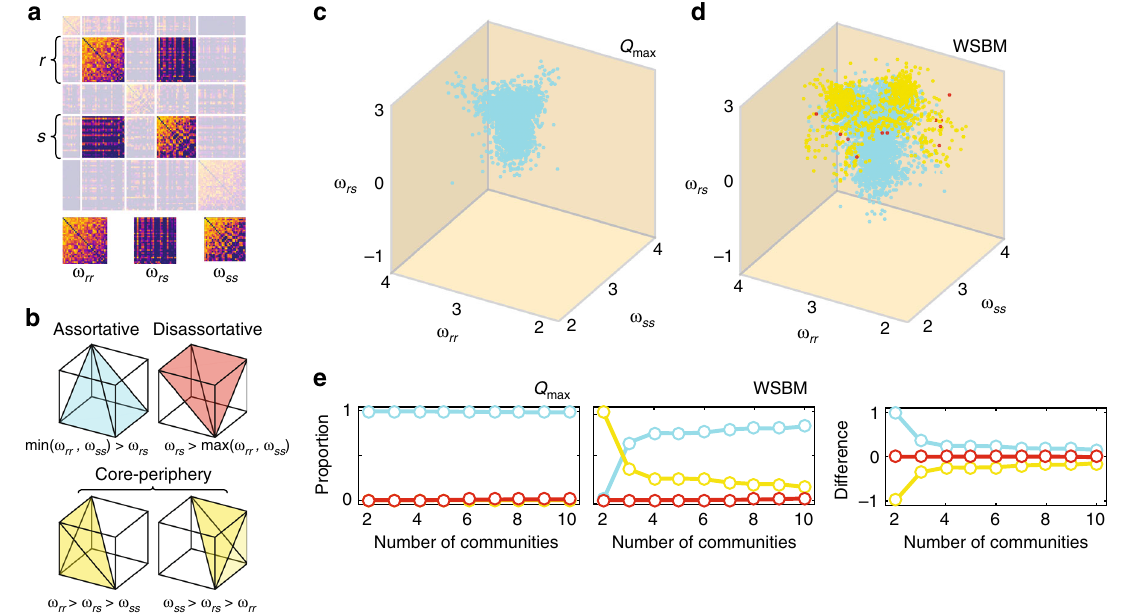
Fig. 6 A rich community morphospace. a A community motif is constructed on the average connection weight over blocks of the connectivity matrix. Here, we show blocks within and between two communities, labeled r and s . b Given within-community and between-community connection densities, it is possible to classify each pair of communities into one of three motifs: assortative, disassortative, or core-periphery. c , d All pairs of communities placed in a network morphospace and colored by their motif type (note: axes are log-scaled). e The relative proportion of each motif type as a function of the number of detected communities, K , for Q max (left), the WSBM (middle), and their difference (right). Note: The WSBM does, in fact, generate a small fraction of disassortative communities and so points on the red curves in D and E are not equal to